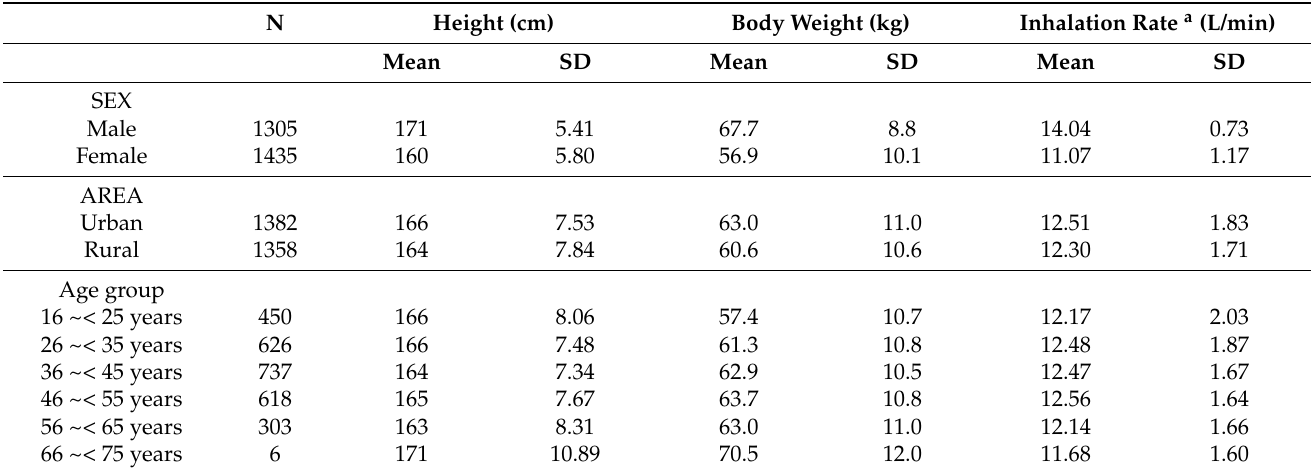
Table 1. Basic information of participants in